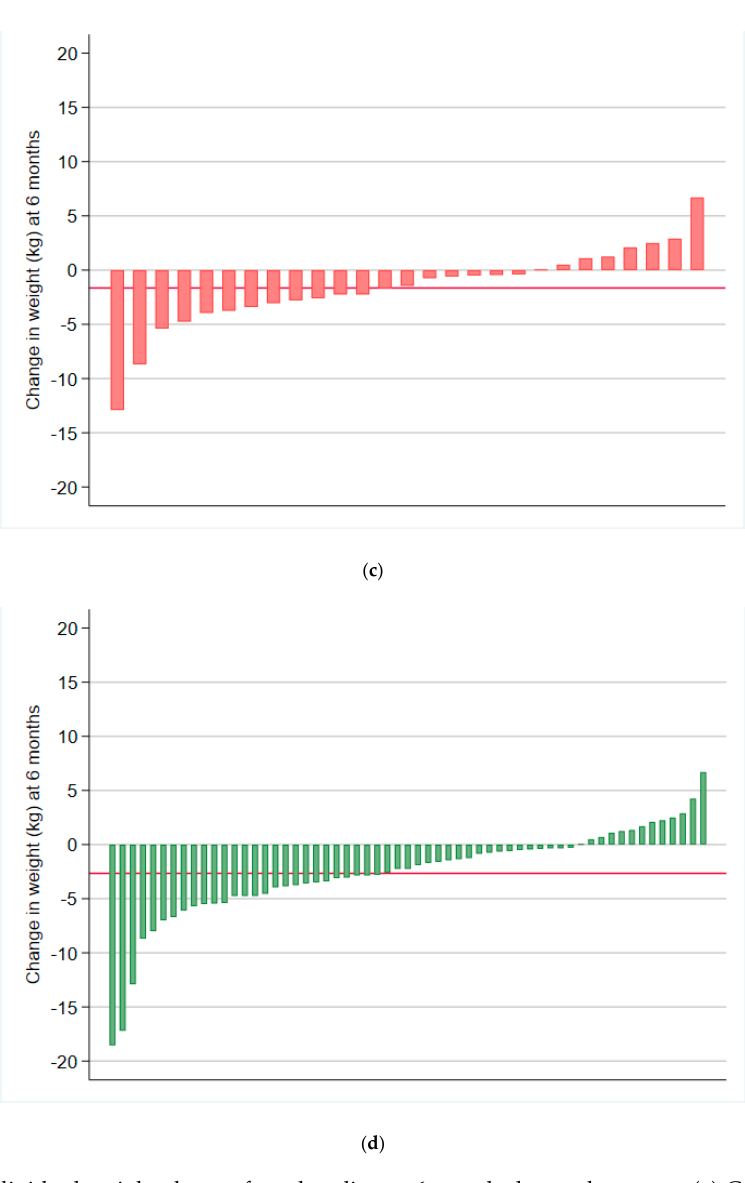
Figure 2. Individual weight change from baseline to 6 months by study group. ( a ) Control group participant change at 6 months; ( b ) Traditional group participant change at 6 months; ( c ) Enhanced group participant change at 6 months; ( d ) Pooled group participant change at 6 months.